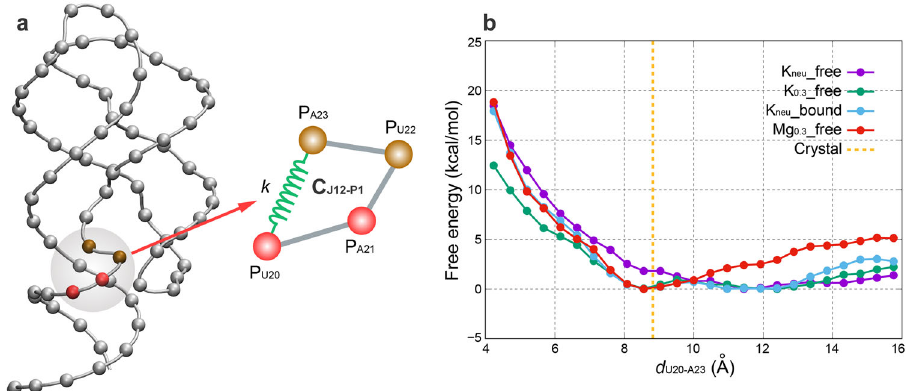
Fig. 3 The free energy landscape of AARA in different ionic environments. a The schematic diagram of reaction coordinate selection. The distance between residues U20 and A23 was chosen as the reaction coordinate, and constraints with a harmonic force constant of 5 kcal·mol − 1 ·Å − 2 was applied between them. b Potential of mean force from umbrella sampling simulations showing the relative free-energy landscapes of all four systems along the d d U20-A23 coordinate space, and the orange dashed line corresponds to U20-A23 in the crystal structure (~8.8 Å). The error bars calculated through Monte Carlo bootstrapping is smaller than the size of data point and cannot be shown in the fi gure.